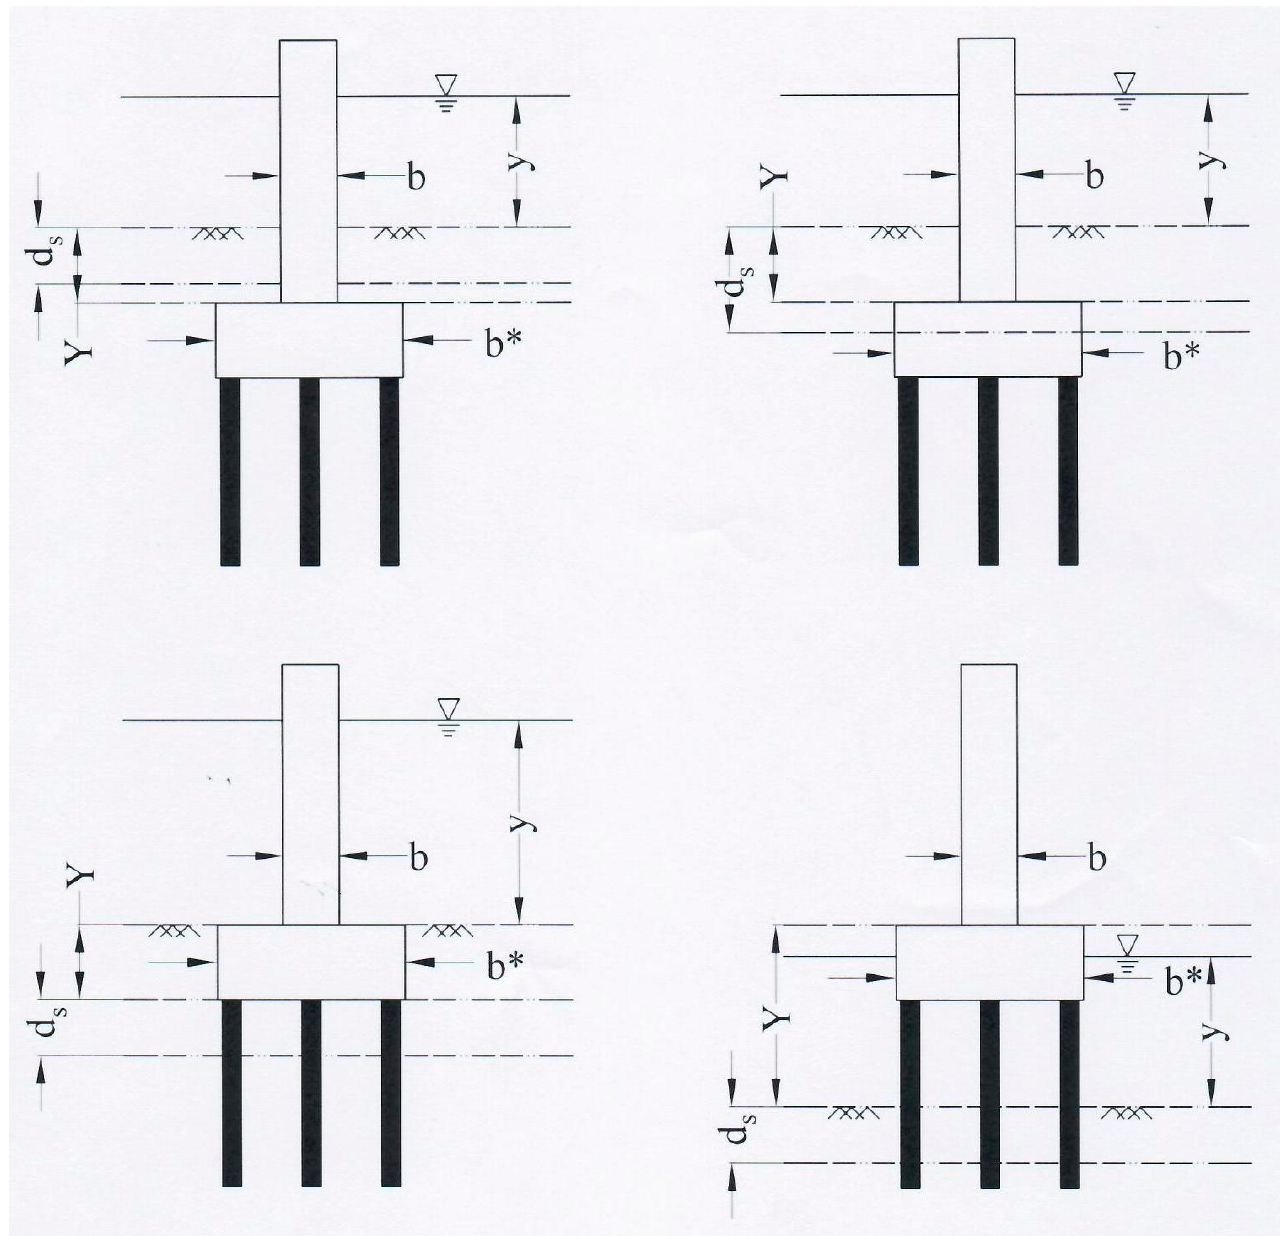
Figure 1. Different pier configurations considered: Case I ( top-left ), case II ( top-right ), case III ( bottom-left ), and case IV ( bottom-right ).